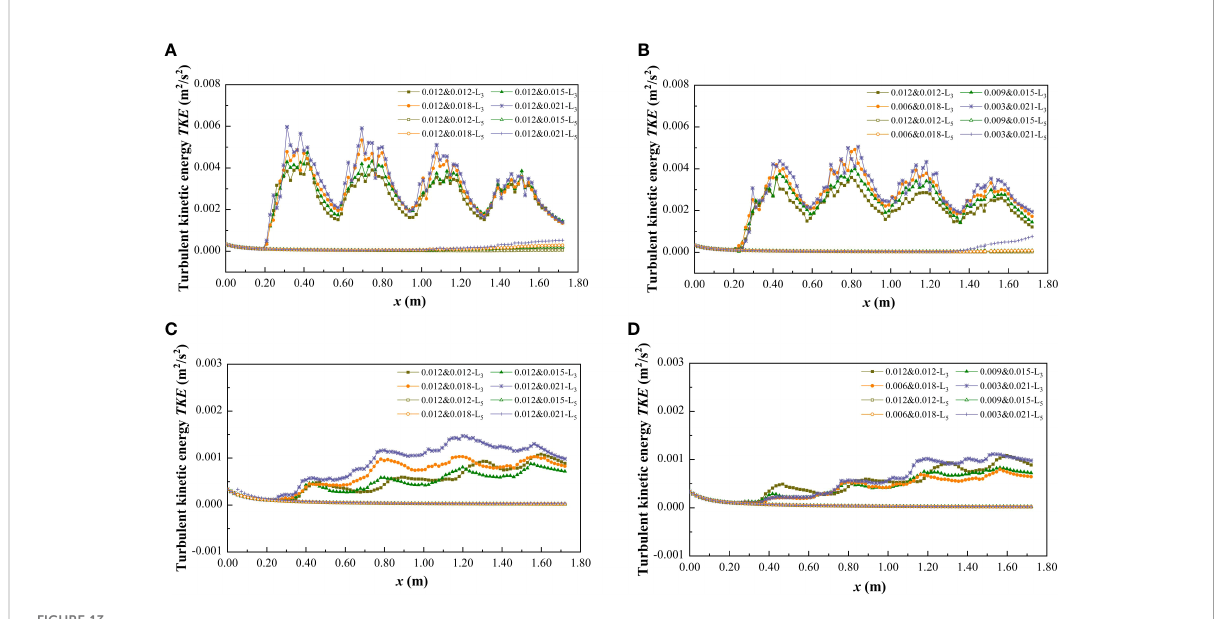
FIGURE 13 Turbulent kinetic energy distribution of longitudinal sections L 3 and L 5 at h = 0.06 m and 0.10 m under different submerged conditions. (A) h = 0.06 m, vegetation combination distribution, non-submerged vegetation, (B) h = 0.06 m, vegetation discrete distribution, non-submerged vegetation, (C) h = 0.10 m, vegetation combination distribution, submerged vegetation, (D) h = 0.10 m, vegetation discrete distribution, submerged